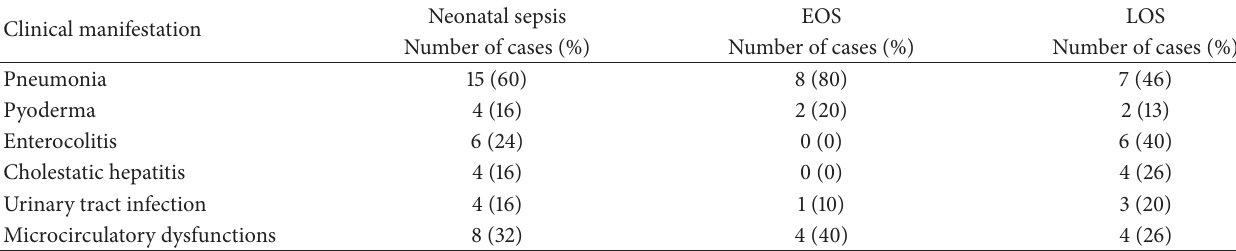
Table 1: Clinical manifestations associated with different types (EOS and LOS) of neonatal sepsis.